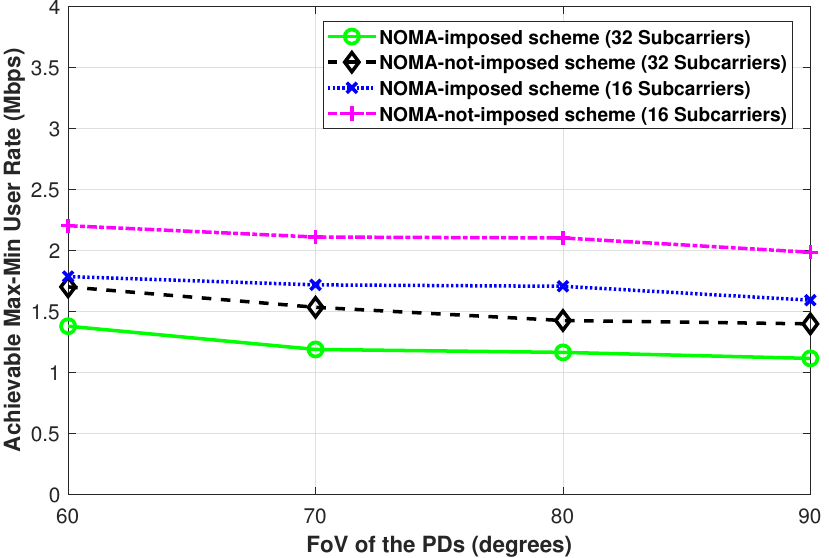
Figure 8. The achievable max-min user rate of the NOMA-imposed scheme and the NOMA-not- imposed scheme obtained while changing the FoV of the PDs. ( P e = 35 dBm, L = 4, N = 20, φ 1/2 = 60 ◦